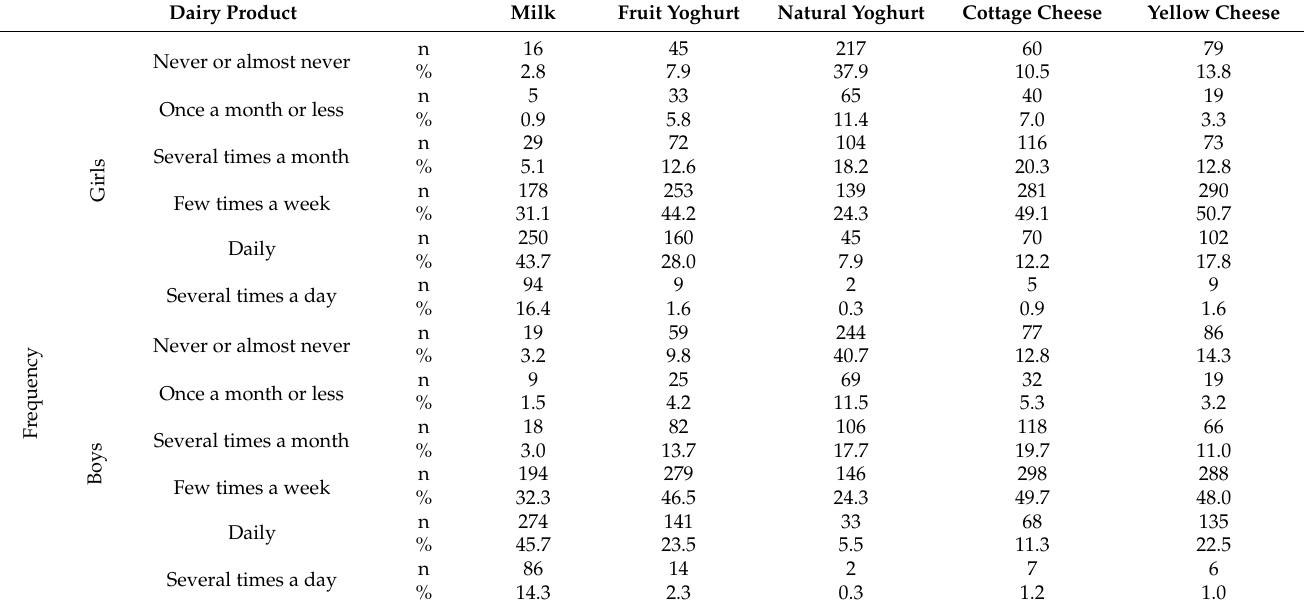
Table 2. The frequency of dairy products consumption among the study